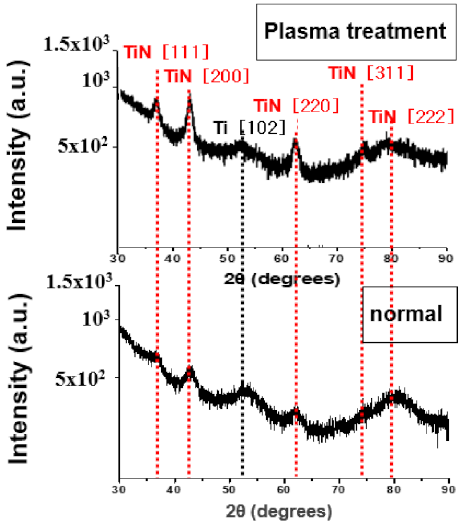
Figure 10. XRD images before and after plasma treatment of TiN thin films deposited at a deposition temperature of 400 ◦ C.